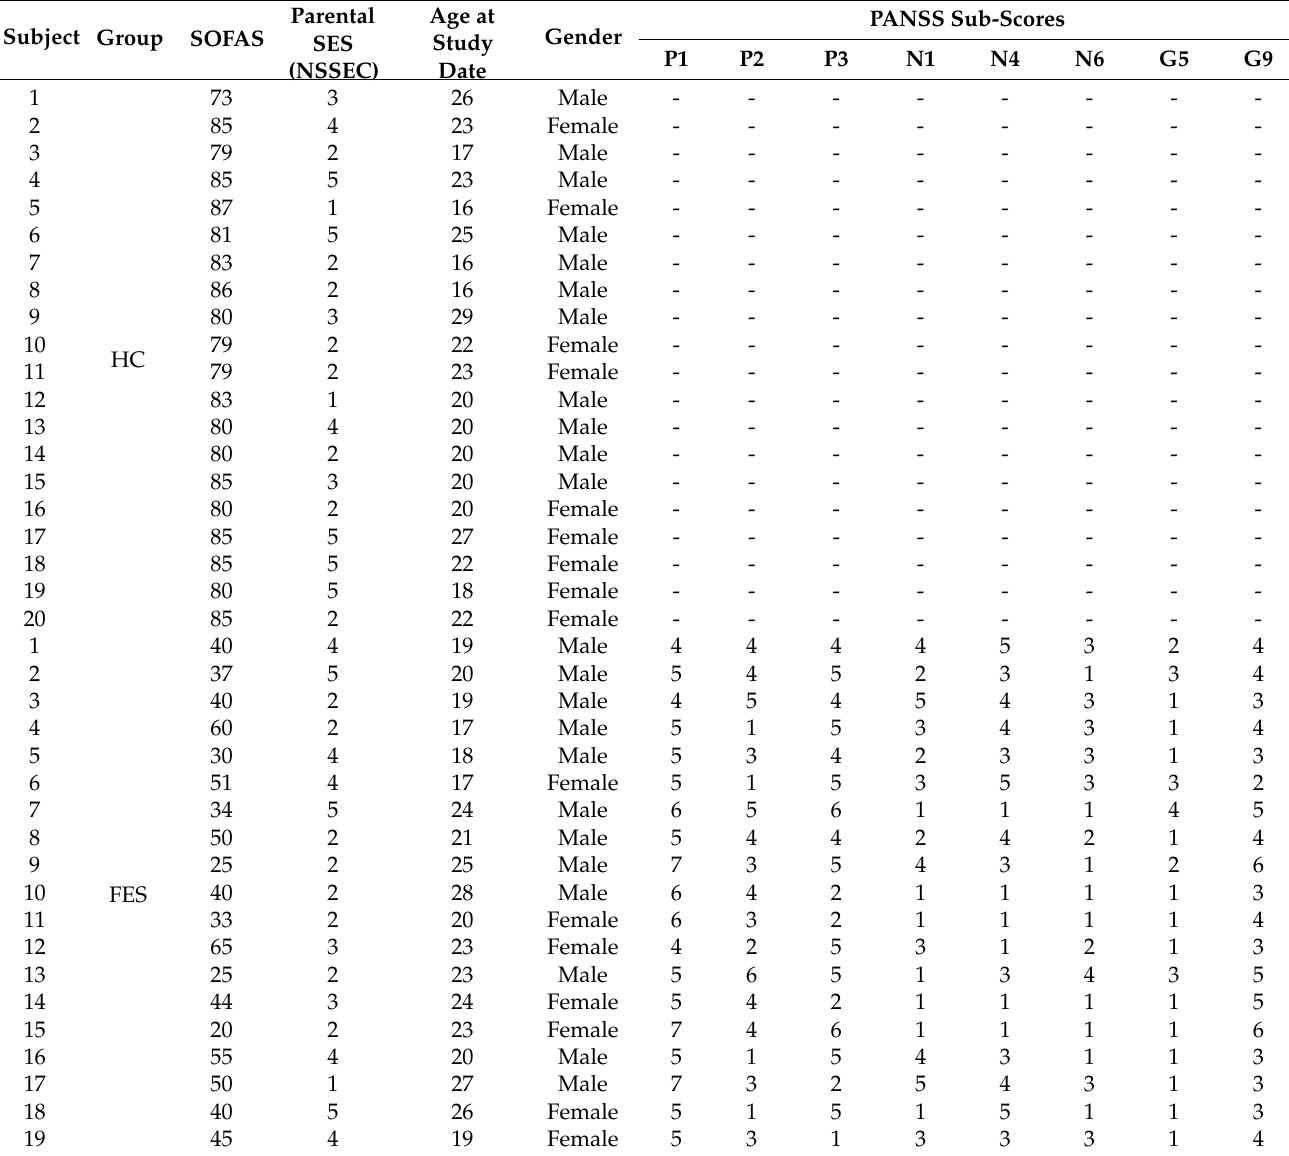
Table 1. Demographics and clinical